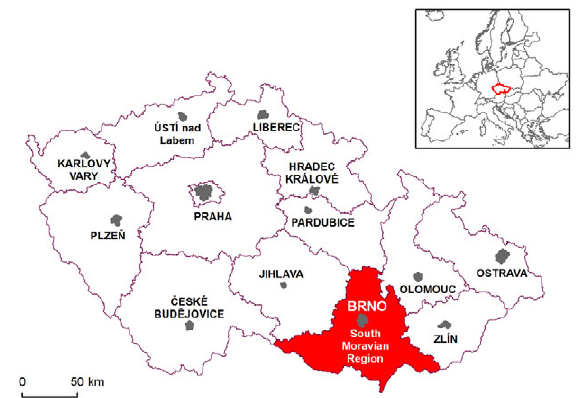
Fig. 1. The position of the study area (Brno city) within the South Moravian region and the Czech